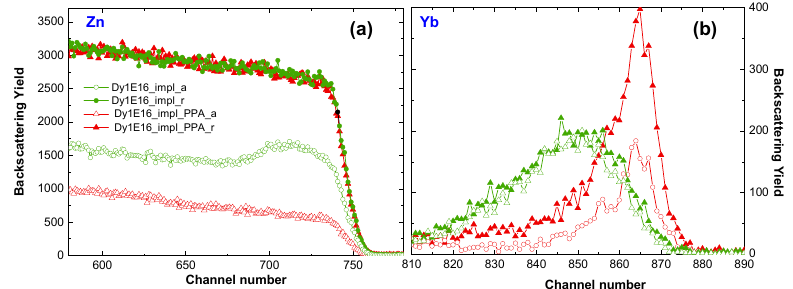
Figure 5. ( a , b ) Random and aligned RBS spectra obtained for ZnO implanted with 150 keV Dy ions to the fluence of 1 × 10 16 /cm 2 and subsequently annealed using plasma pulse annealing with a pulse energy of 1.17 J/cm 2 . 318